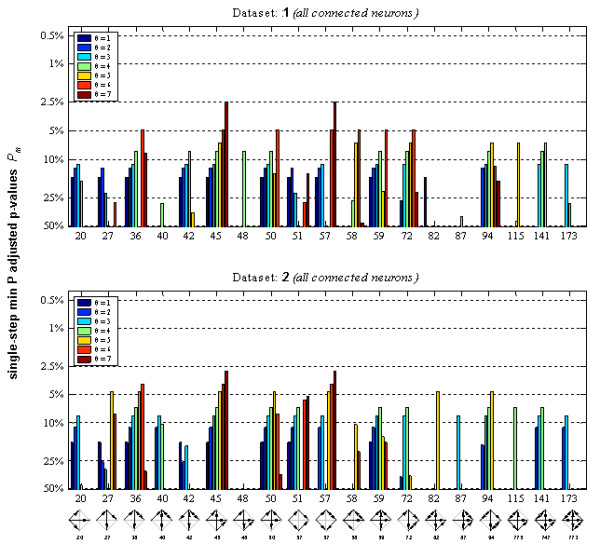
Significance measure Pm of selected quadruplet over-representation for different thresholds. Multiple hypothesis testing corrected p-values for the quadruplet over-representation in datasets 1 and 2 (n = 1000). The patterns shown satisfy the following selection criteria: There must be a significant value Pm < 0.1 for at least one Θ and the count of this pattern in C. elegans must be at least 5. All random matrices in the ensemble (n = 1000) preserve the number of uni- and bi-directional connections for each neuron as well as the count in all triplet classes for the whole network.